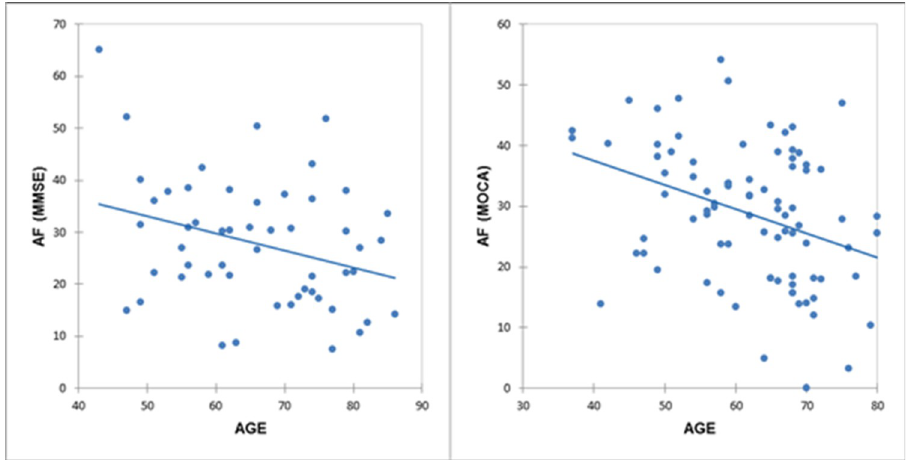
Fig 2. Correlations between age and alternate fluency with the sample stratified for MMSE or MOCA. AF/MMSE: r = − 0.28, p = 0.04; AF/MOCA: r = − 0.35, p = 0.001. AF , Alternate Fluency; MMSE , Mini Mental State Examination; MOCA , Montreal Cognitive